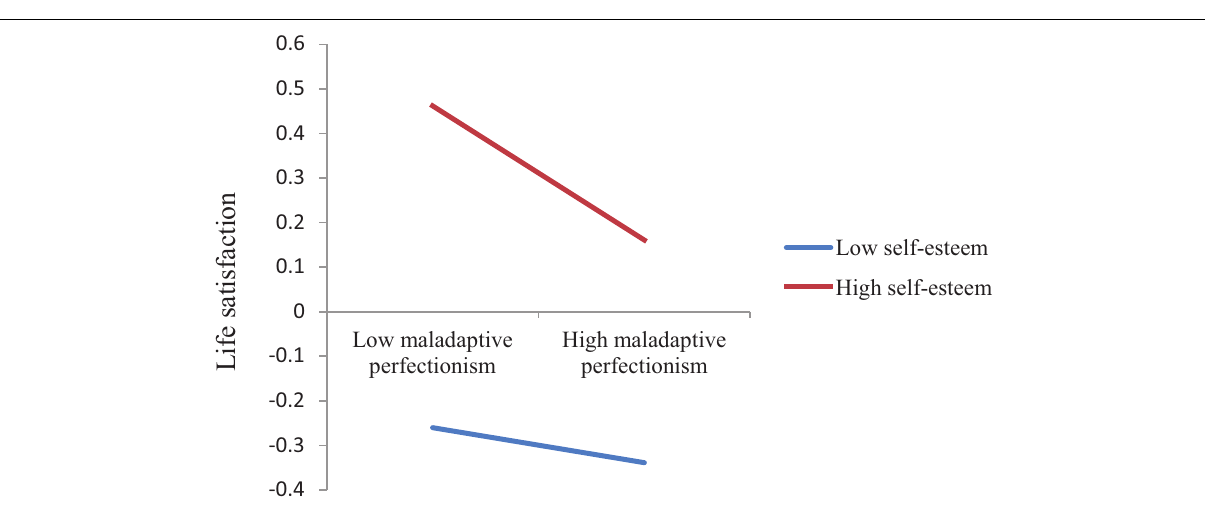
satisfaction through the mediating effect of academic burnout [ β = − 0.019, SE = 0.009, 95%CI = ( − 0.038, −